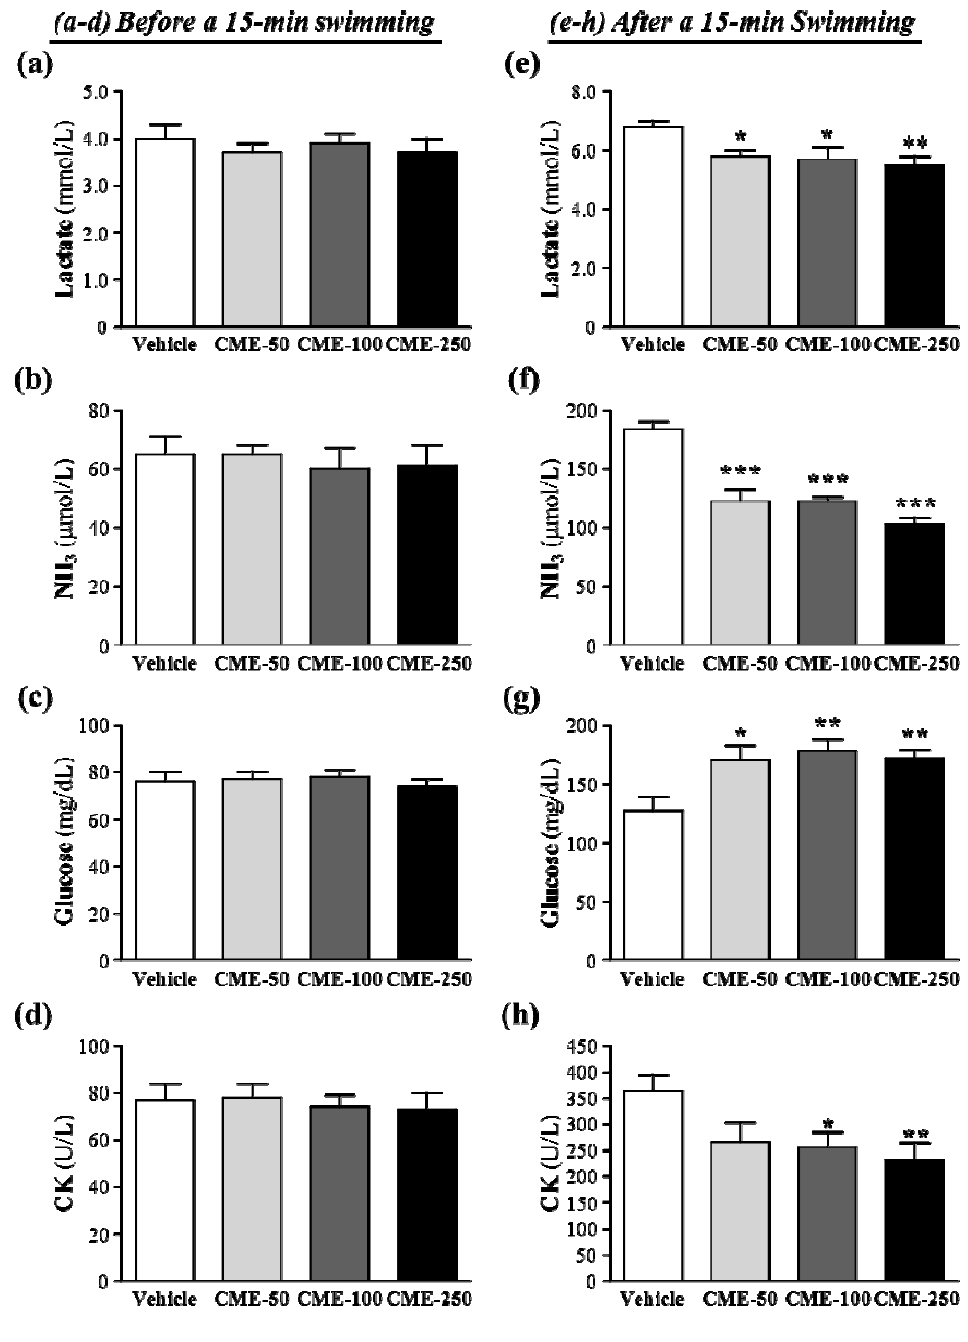
Figure 1. Effect of CME supplementation on plasma ( a , e ) lactate, ( b , f ) ammonia, ( c , g ) glucose levels and ( d , h ) creatine kinase (CK) levels before and after an acute exercise challenge. Mice were pretreated with vehicle, 50, 100, and 250 mg/kg of CME for 14 days, then 1 h later performed a 15-min swimming test without weight-loading. Data represent mean ± SEM of 8 mice in each group. * p < 0.05; ** p < 0.01; *** p < 0.001 compared to vehicle